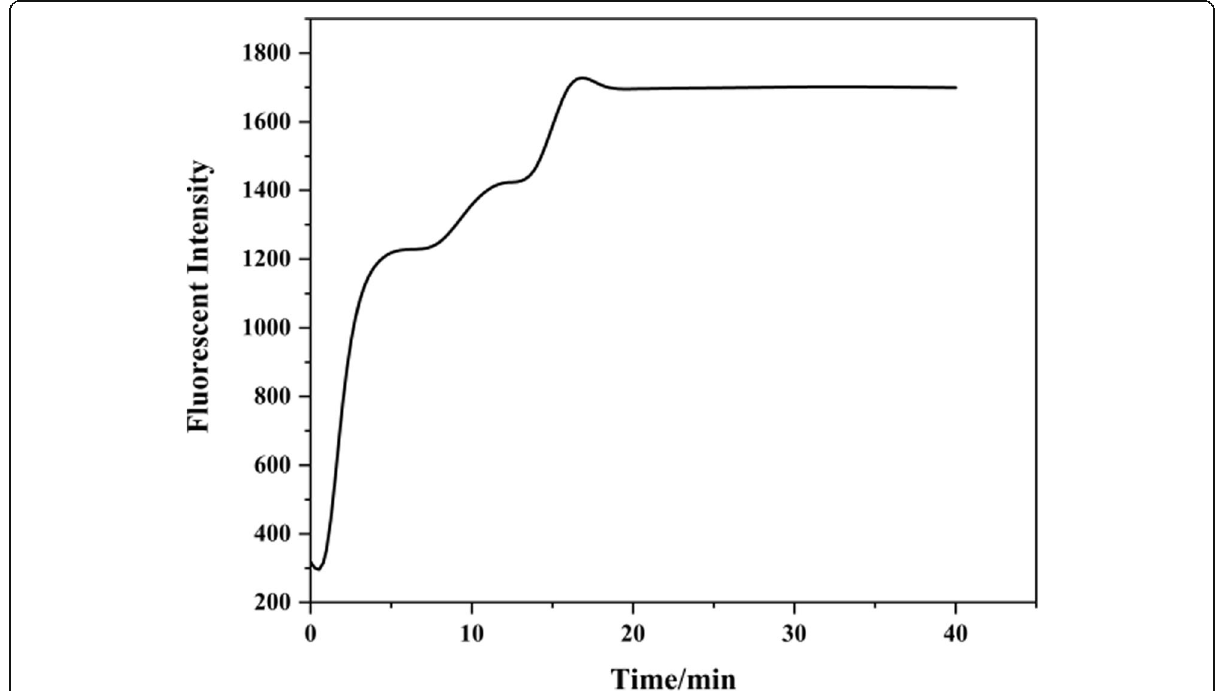
Fig. 5 Fluorescence response time of 10 μ M BCT in PBS buffer (10 mM, pH 7.4) to 25 μ M O 3 aqueous